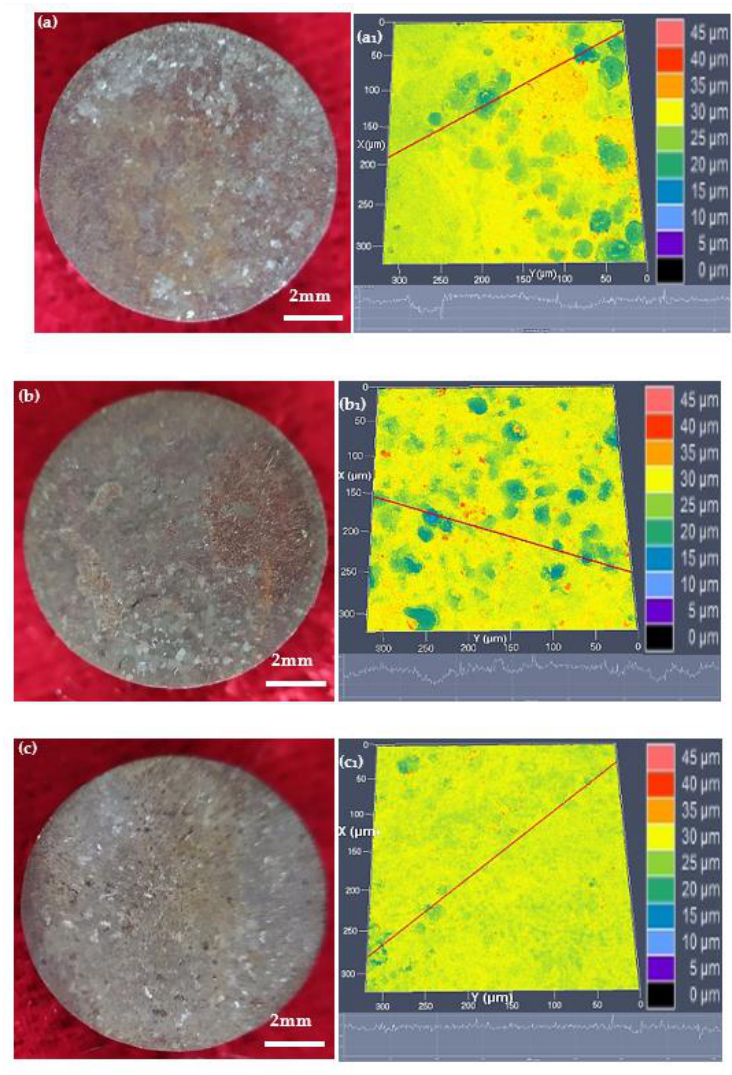
Figure 6. Surface morphologies (( a – c )) and topographic maps (( a 1 – c 1 )) of the different annealed conditions: ( a , a 1 ) for annealed at 765 °C, ( b , b 1 ) for annealed at 785 °C, ( c , c 1 ) for annealed at 805 °C.